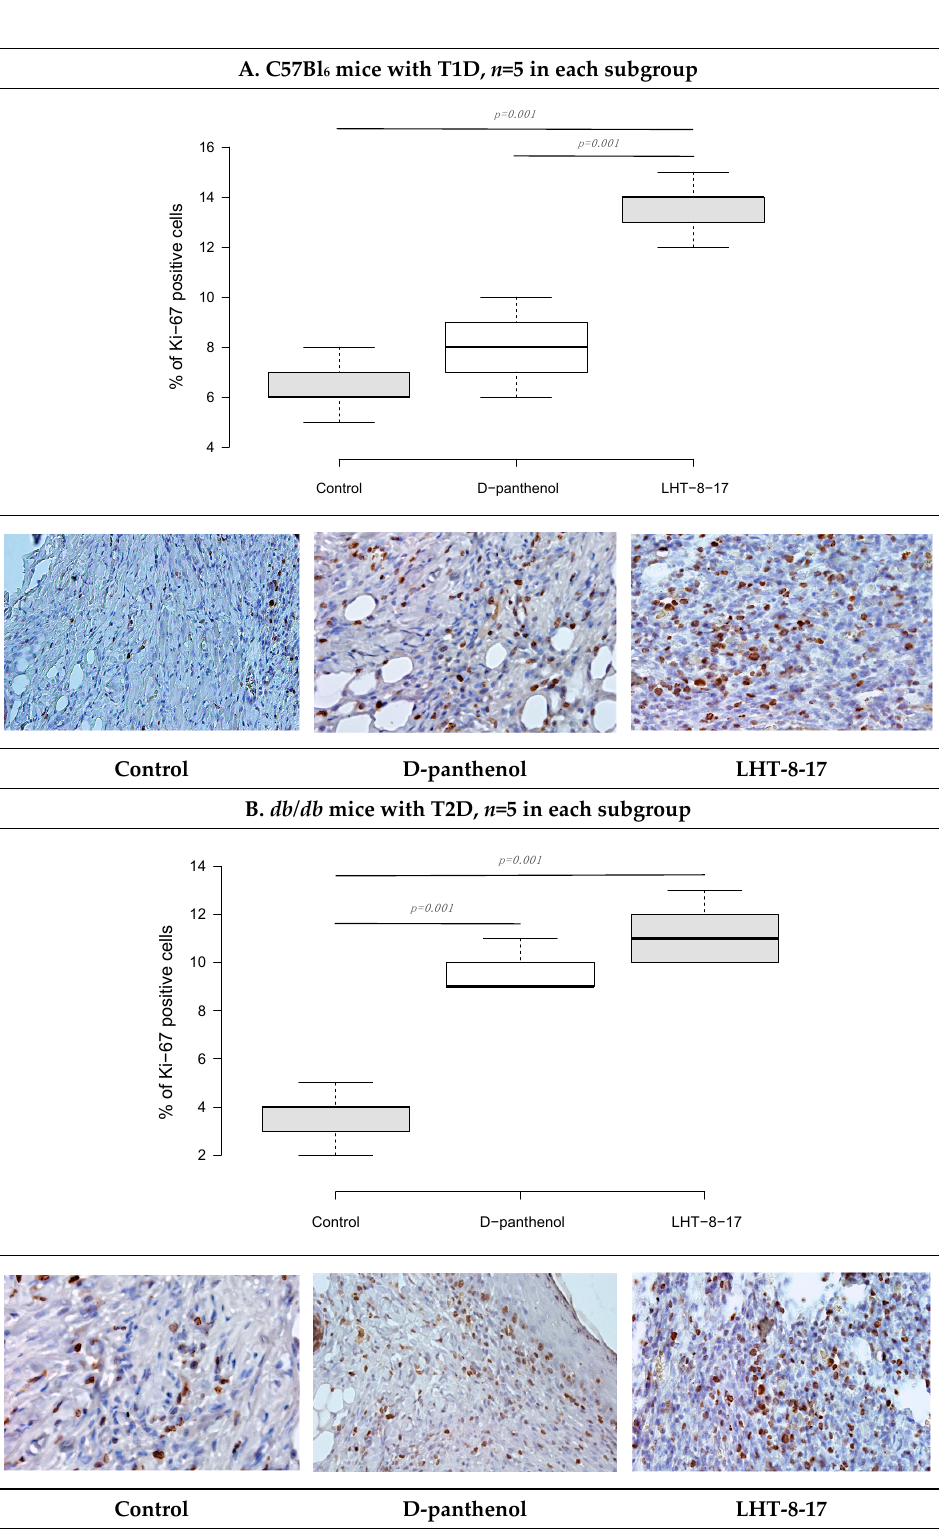
Figure 9. Cellular Ki-67 expression status in wound tissues of animals with T1D and T2D topically treated with 4 mg cerium-containing formulation twice daily, on day 10 of the observation: ( A , B )—T1D and T2D models; quantitative estimation of Ki67 cell positivity presented as the median ± SD; significance of differences was estimated using ANOVA and the Tukey criterion; wound tissue sections stained by rabbit monoclonal anti-Ki-67 antibody, IHC, 400×.